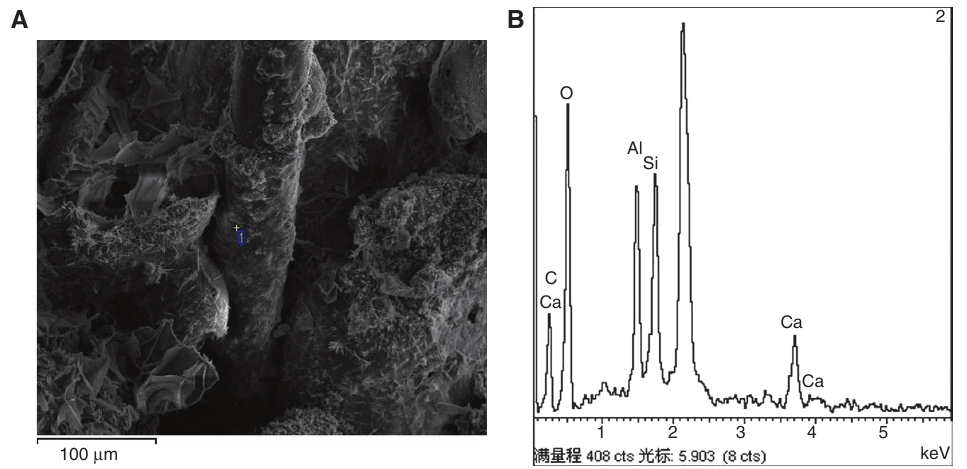
Figure 8 Micromorphology of glass fiber on the fracture of sample S3. (A) Smaller magnification. (B) Energy spectrum of point 1 in panel